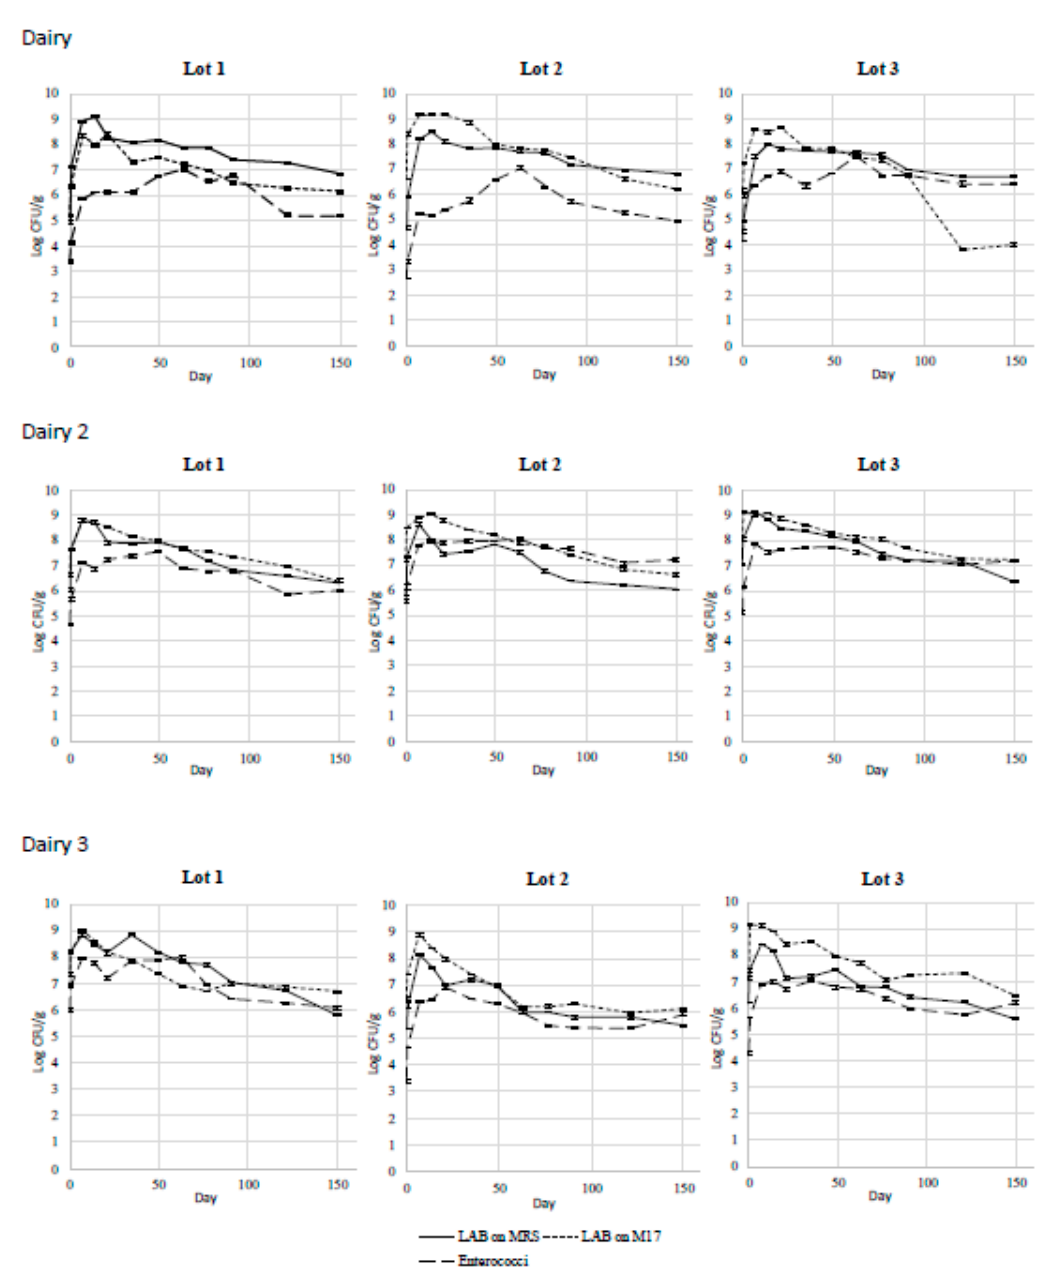
Figure 1. Evolution of LAB in nine lots of Pecorino di Farindola cheese from three manufacturers (Dairy 1, 2 and 3).